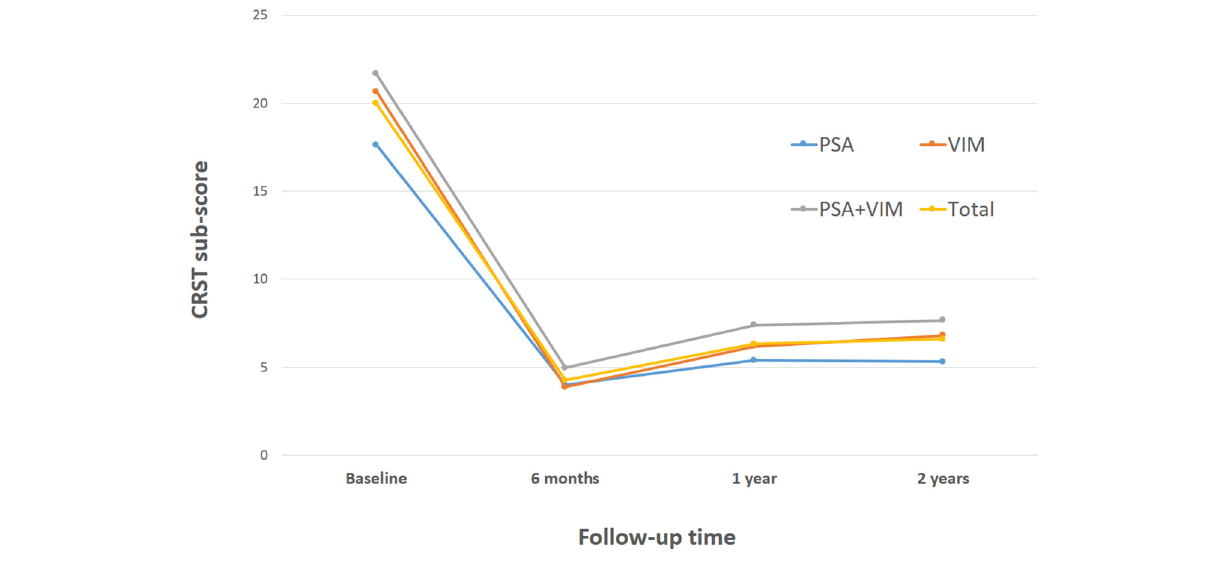
FIGURE 2 | Changes of Clinical Rating Scale for Tremor (CRST) subscores over time. CRST subscores at evaluation visits. The graphs represent LSmeans and SE of the CRST subscores at different evaluation visits. PSA, posterior subthalamic area; VIM, ventral intermediate nucleus of the thalamus.